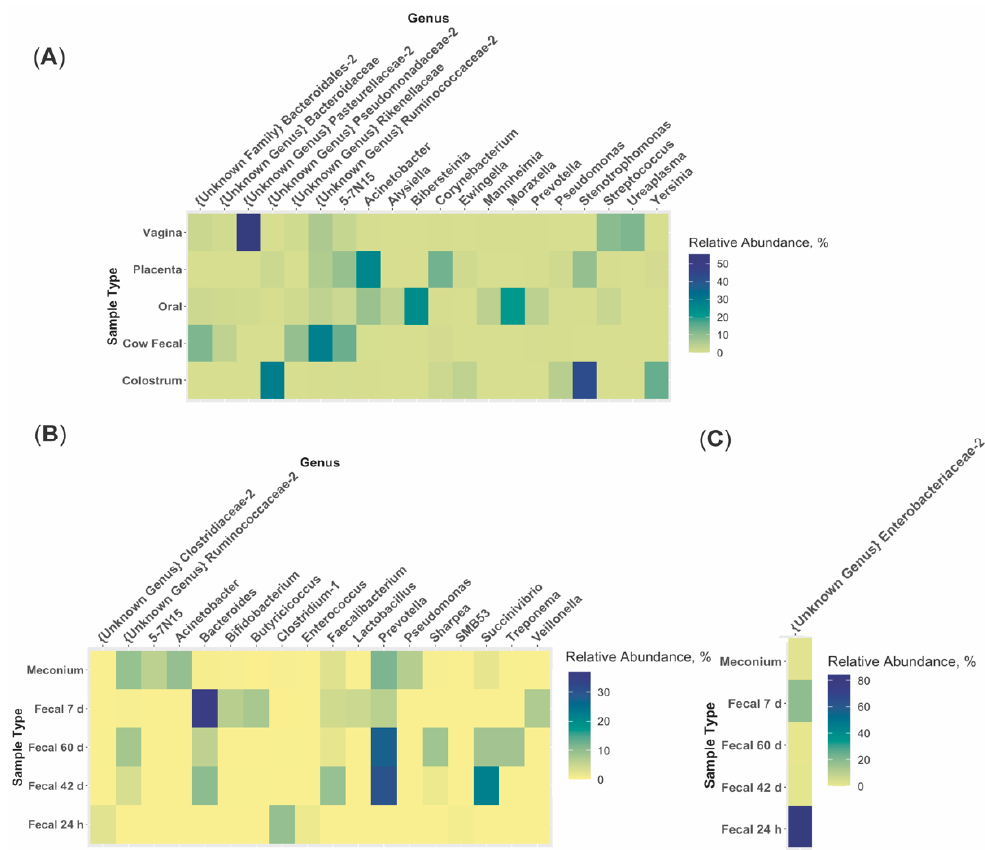
Figure 3. Relative abundance of phyla in each multiparous Holstein maternal (placenta, colostrum, oral, fecal, n = 6; vaginal, n = 4) and calf (meconium, 24 h, 7d, 42 d, and 60 d fecal; n = 6) sample type. Proteobacteria were the dominant phylum within placenta, vagina, colostrum, oral, and 24 h calf fecal samples, while Bacteroides were the dominant phylum in dam fecal, meconium, 7 d, 42 d, and 60 d calf fecal samples.